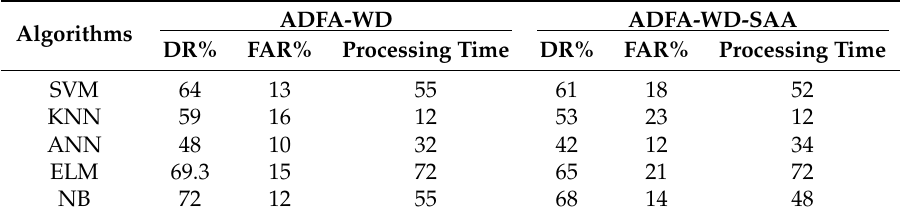
Table 2. Complexity of data sets using DDLLC as feature